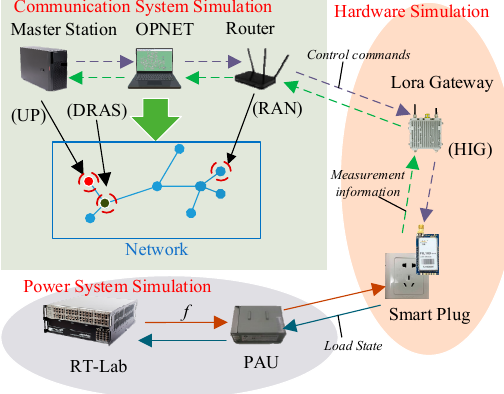
Figure 10. Hardware-in-loop co-simulation platform.